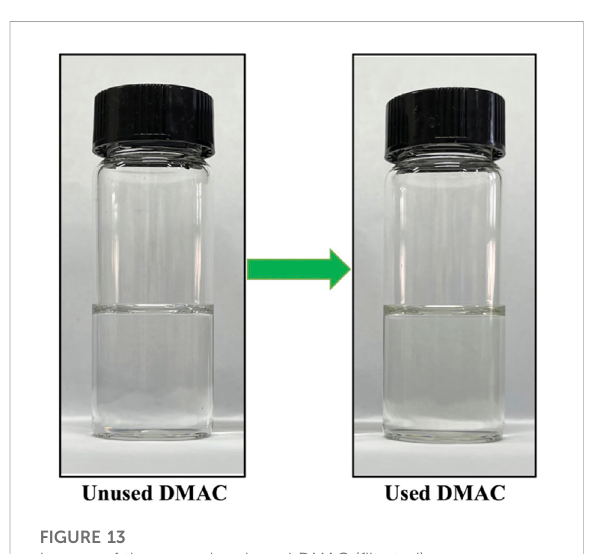
FIGURE 13 Images of the unused and used DMAC ( fi ltrated).